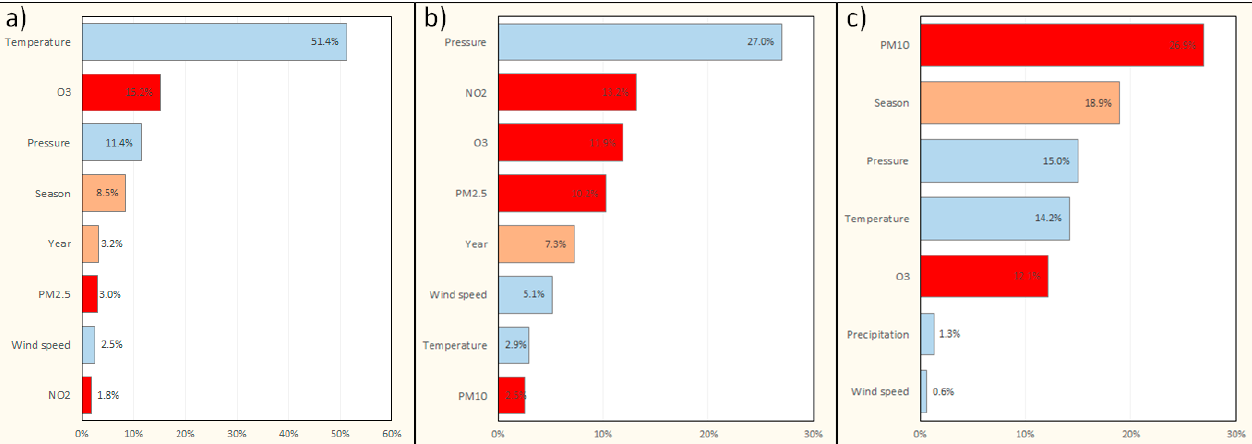
Figure 4. Pareto B graphs showing the impact of the most influential individual variables on the number of deaths in the final models with interactions. ( a ) model for Warsaw; ( b ) model for Cracow; ( c ) model for the Tricity. Factors associated with weather conditions are marked in blue, factors associated with air pollution are marked in red, and factors associated with seasonal/annual variability are marked in orange. PM 2.5 , particulate matter of size 2.5 μ m or less; PM 10 , particulate matter of size 10 μ m or less.